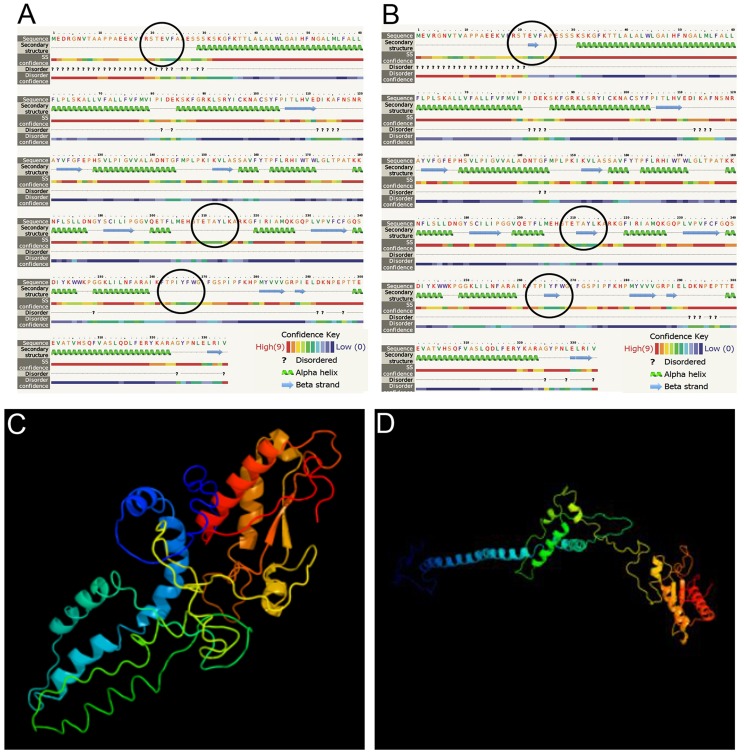
Predicted two and three-dimensional structures of AhDGAT2a and AhDGAT2b.Structures were predicted using phyre2 (http://www.sbg.bio.ic.ac.uk/phyre2/html/page.cgi?id=index). (A, B) Predicted two-dimensional structures of AhDGAT2a and AhDGAT2b, respectively. (C, D) Predicted three-dimensional structures of AhDGAT2a and AhDGAT2b. The rainbow coloration indicates the progression from N (red) → C (indigo) terminus.